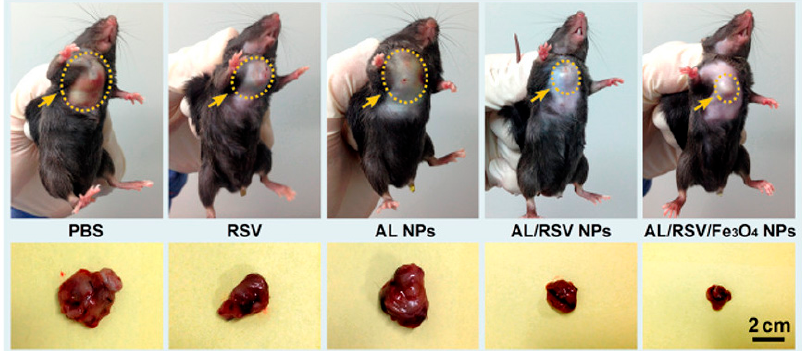
Figure 11. Tumor photographs of mice treated with different nanoparticles, pure Resveratrol and phosphate-buffered saline (PBS) as control. AL/RSV/Fe 3 O 4 , an LNP containing Resveratrol and Fe 3 O